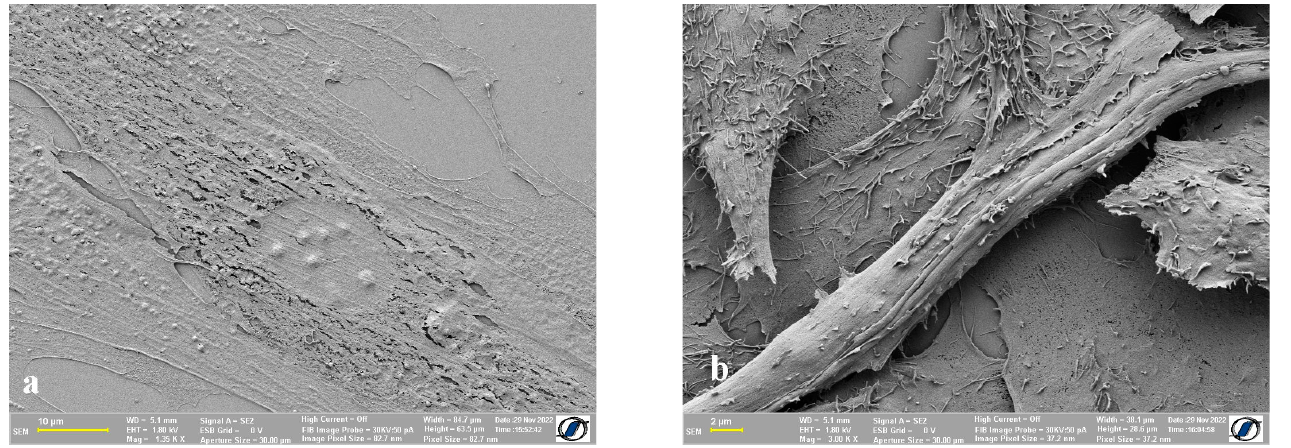
Figure 4. Cells dried using CPD; ( a ) adipose-derived mesenchymal stem cells; ( b ) human osteosarcoma cells.